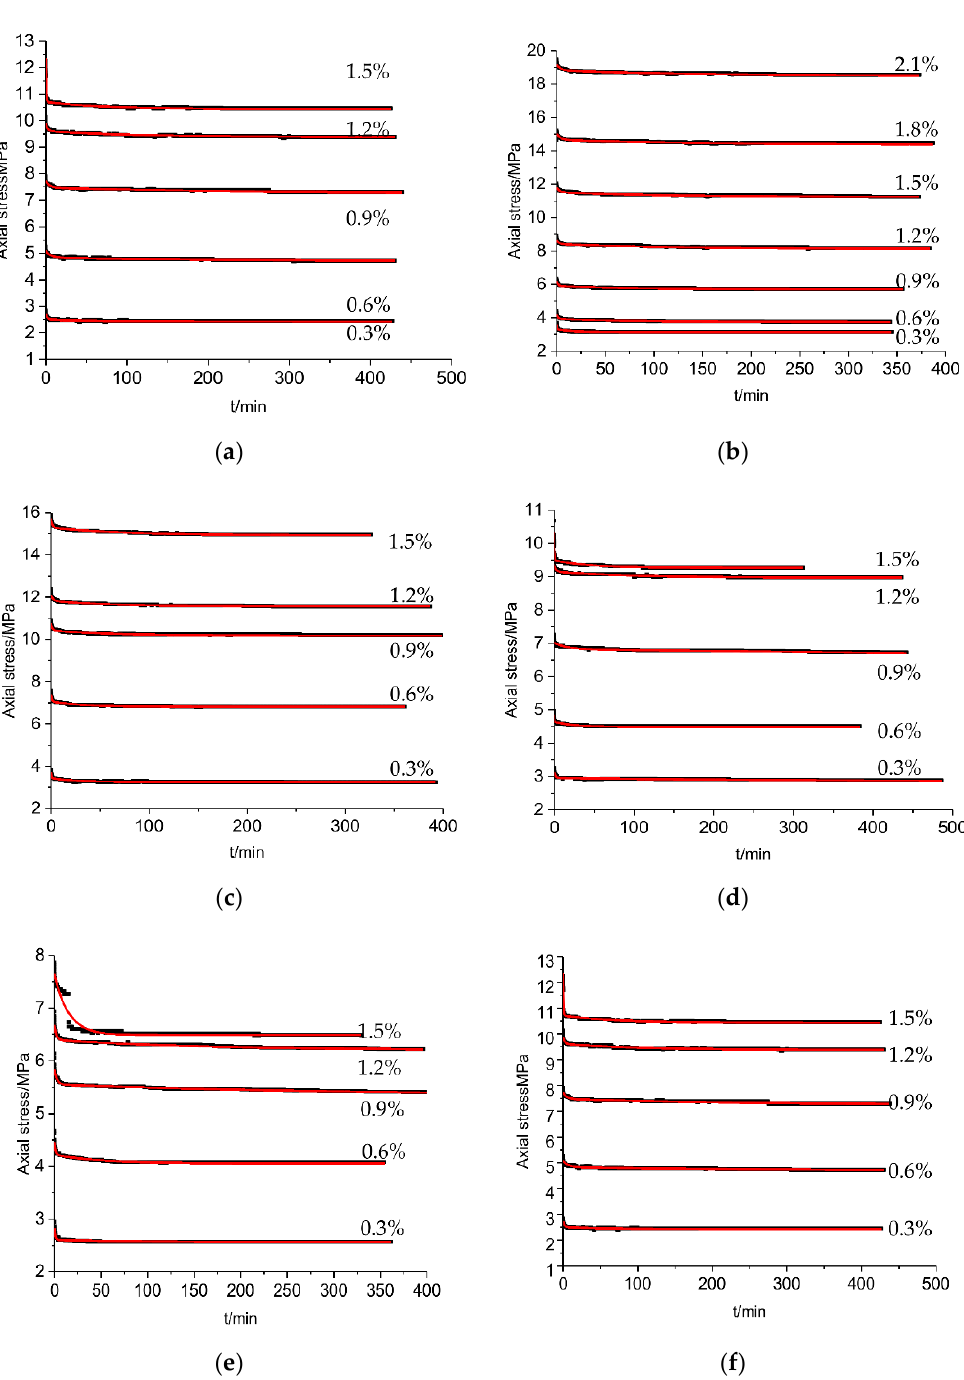
Figure 3. The model validation curves compared to the stress relaxation data of lean coal. Black lines refer to the experimental data and the red lines denote the model curves. ( a ) r-1, ( b ) r-2, ( c ) r-3, ( d ) r-4, ( e ) r-5, ( f ) r-6.